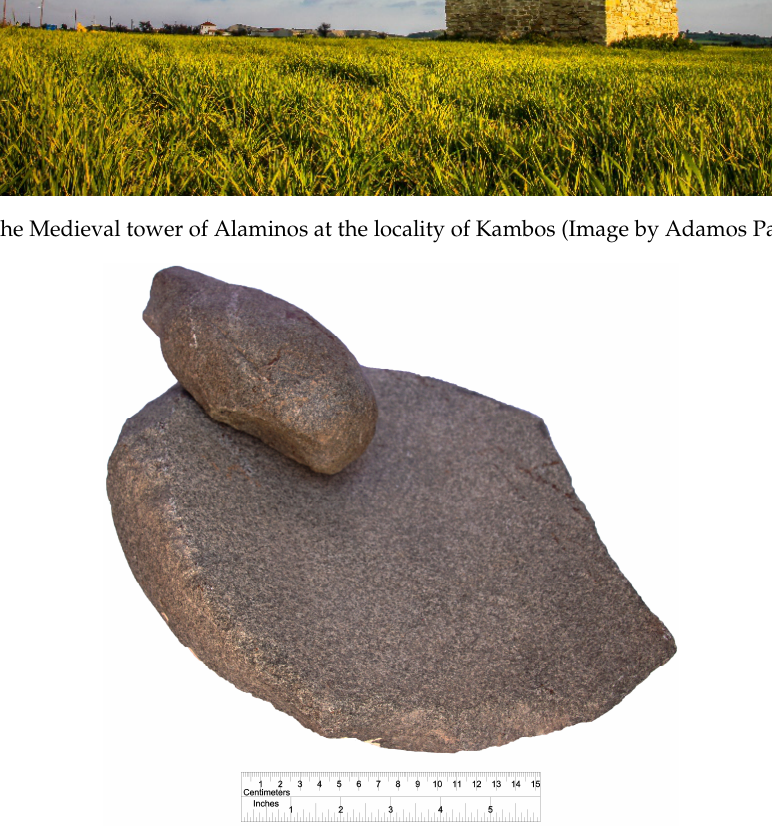
Figure 9. A millstone and grinding tool (Image by Athanasios K.